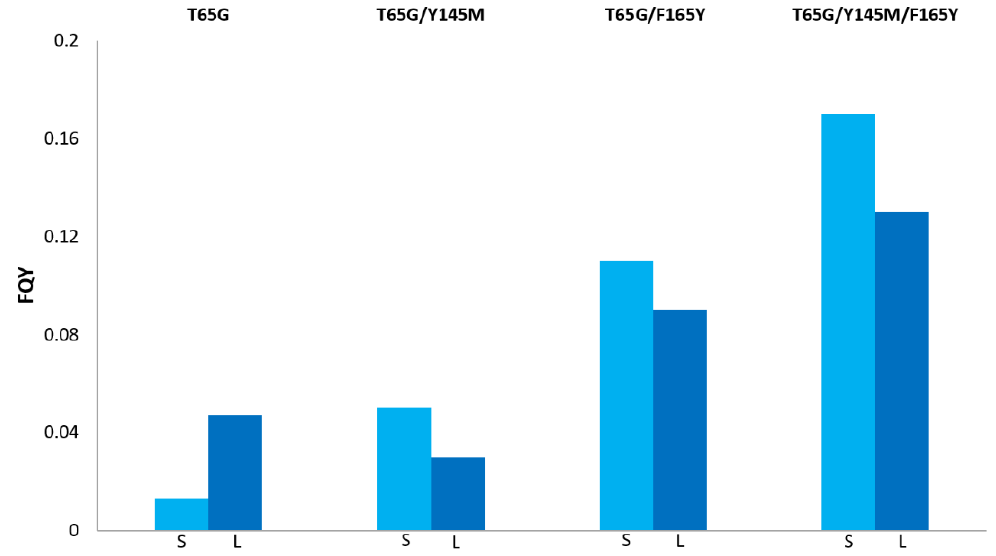
Figure 2. Estimations of FQYs for the separate components observed in biphasic fluorescence decay of the mutants carrying the GYG chromophore. Light blue (S) columns depict the FQY of the short-lived component, deep blue (L) of the long-lived one.